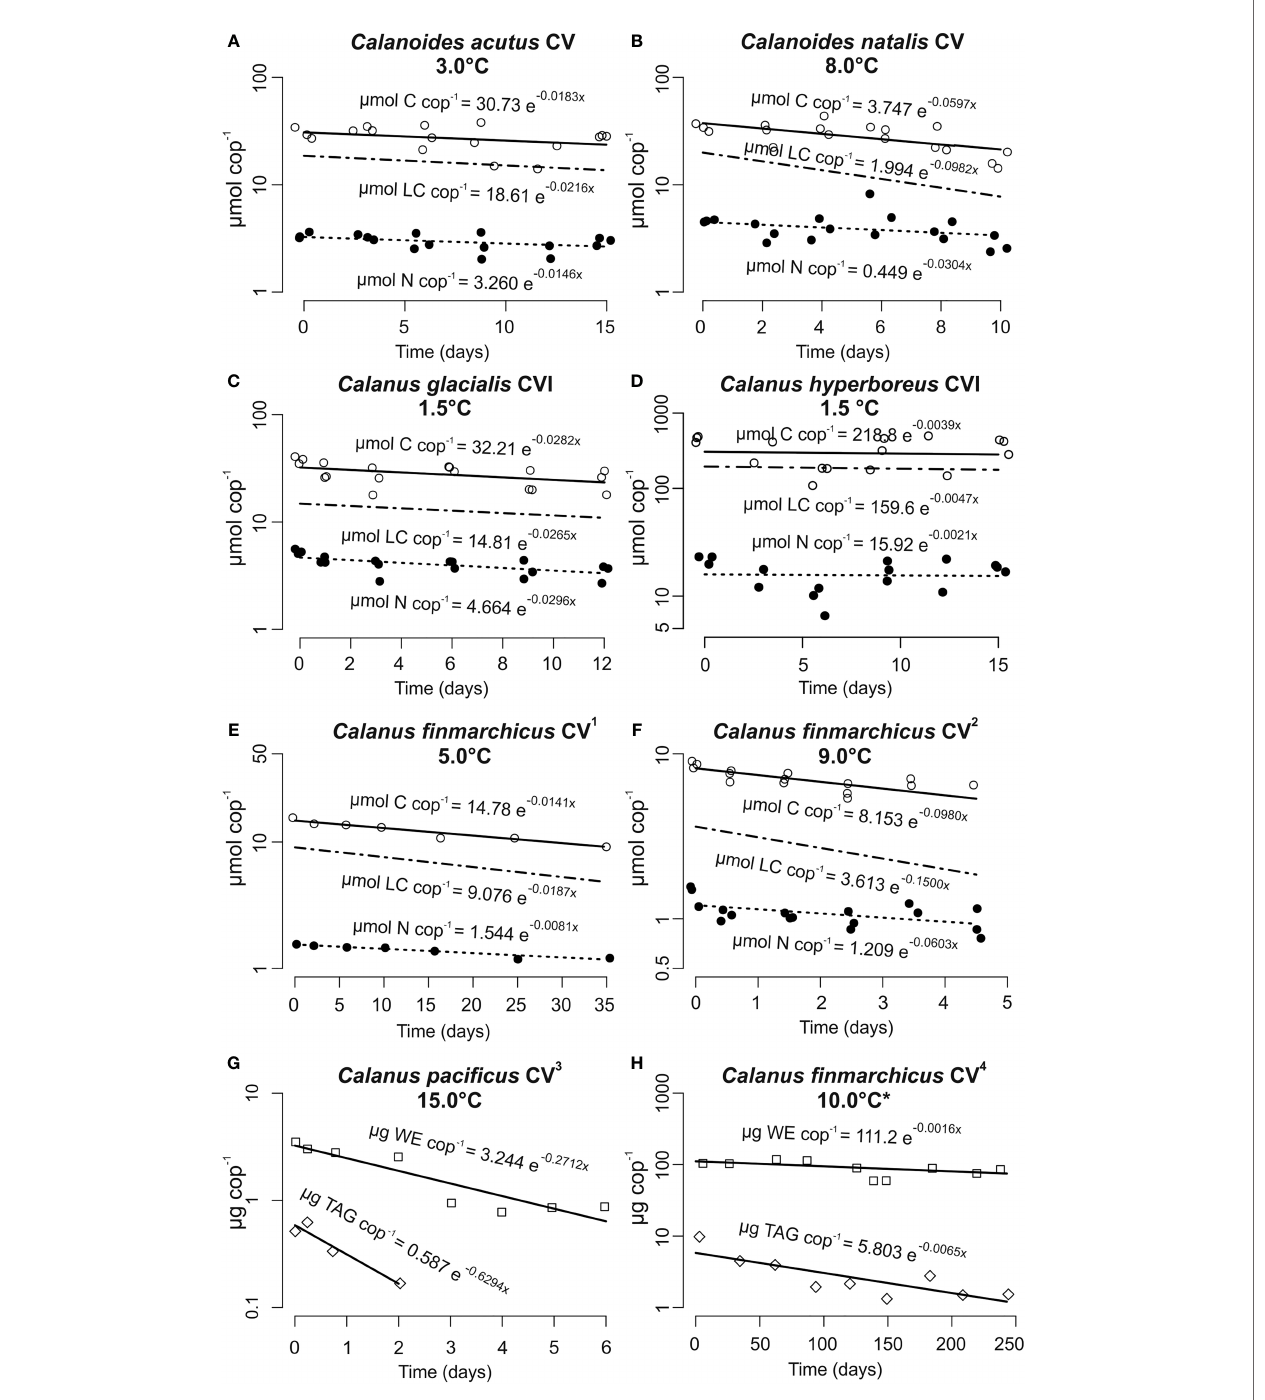
FIGURE 1 | Biomass turnover rates of lipid-storing marine calanoid copepods during food deprivation. Note different scales on the x- and y-axes. Equation exponents provide the instantaneous turnover rate (d -1 ) for carbon (C) (open circles); nitrogen (N) ( fi lled circles); lipid carbon (LC, no symbols as data were derived from C and N); wax esters (WE, open squares) and triacylglycerols (TAG, open diamonds). Data extracted from 1 Mayzaud (1976); 2 Mayor et al. (2011); 3 Hakanson (1984); 4 Clark et al. (2012). The total lipid pool in Clark et al. (2012) turned over at -0.0021 d -1 (data not shown); *typical deep-water temperature in Loch Etive (Edwards and Edelsten,